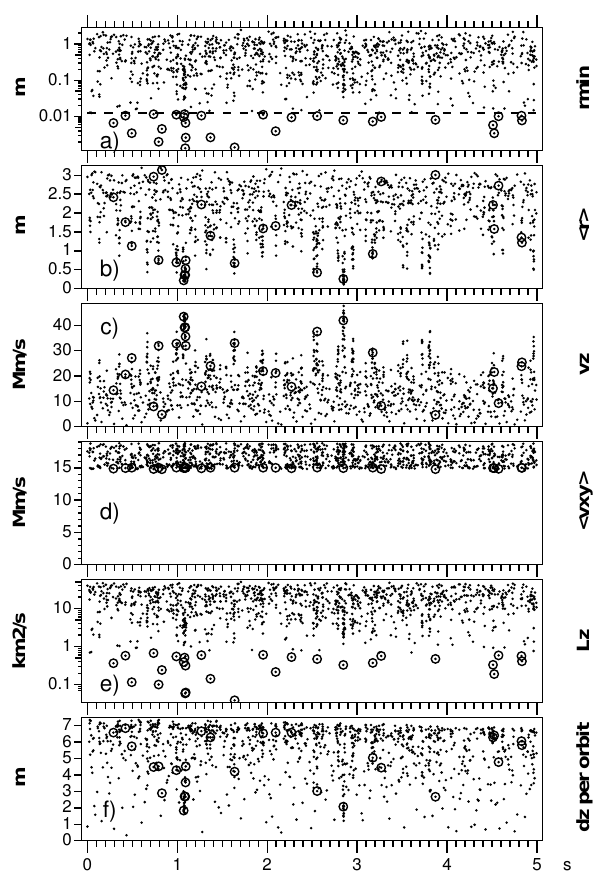
Fig. 6. Tether passes of a test particle calculation: (a) minimum distance from tether, (b) average distance from tether, (c) parallel velocity, (d) orbit-averaged perpendicular velocity, (e) angular mo- mentum component along tether, (f) how much particle advances itself along tether while circling around it for one orbit. Points with minimum distance less than 1.25cm are circled. The 1.25cm limit is indicated by in dashed line in panel (a). The time axis has been scaled to correspond to 20km long